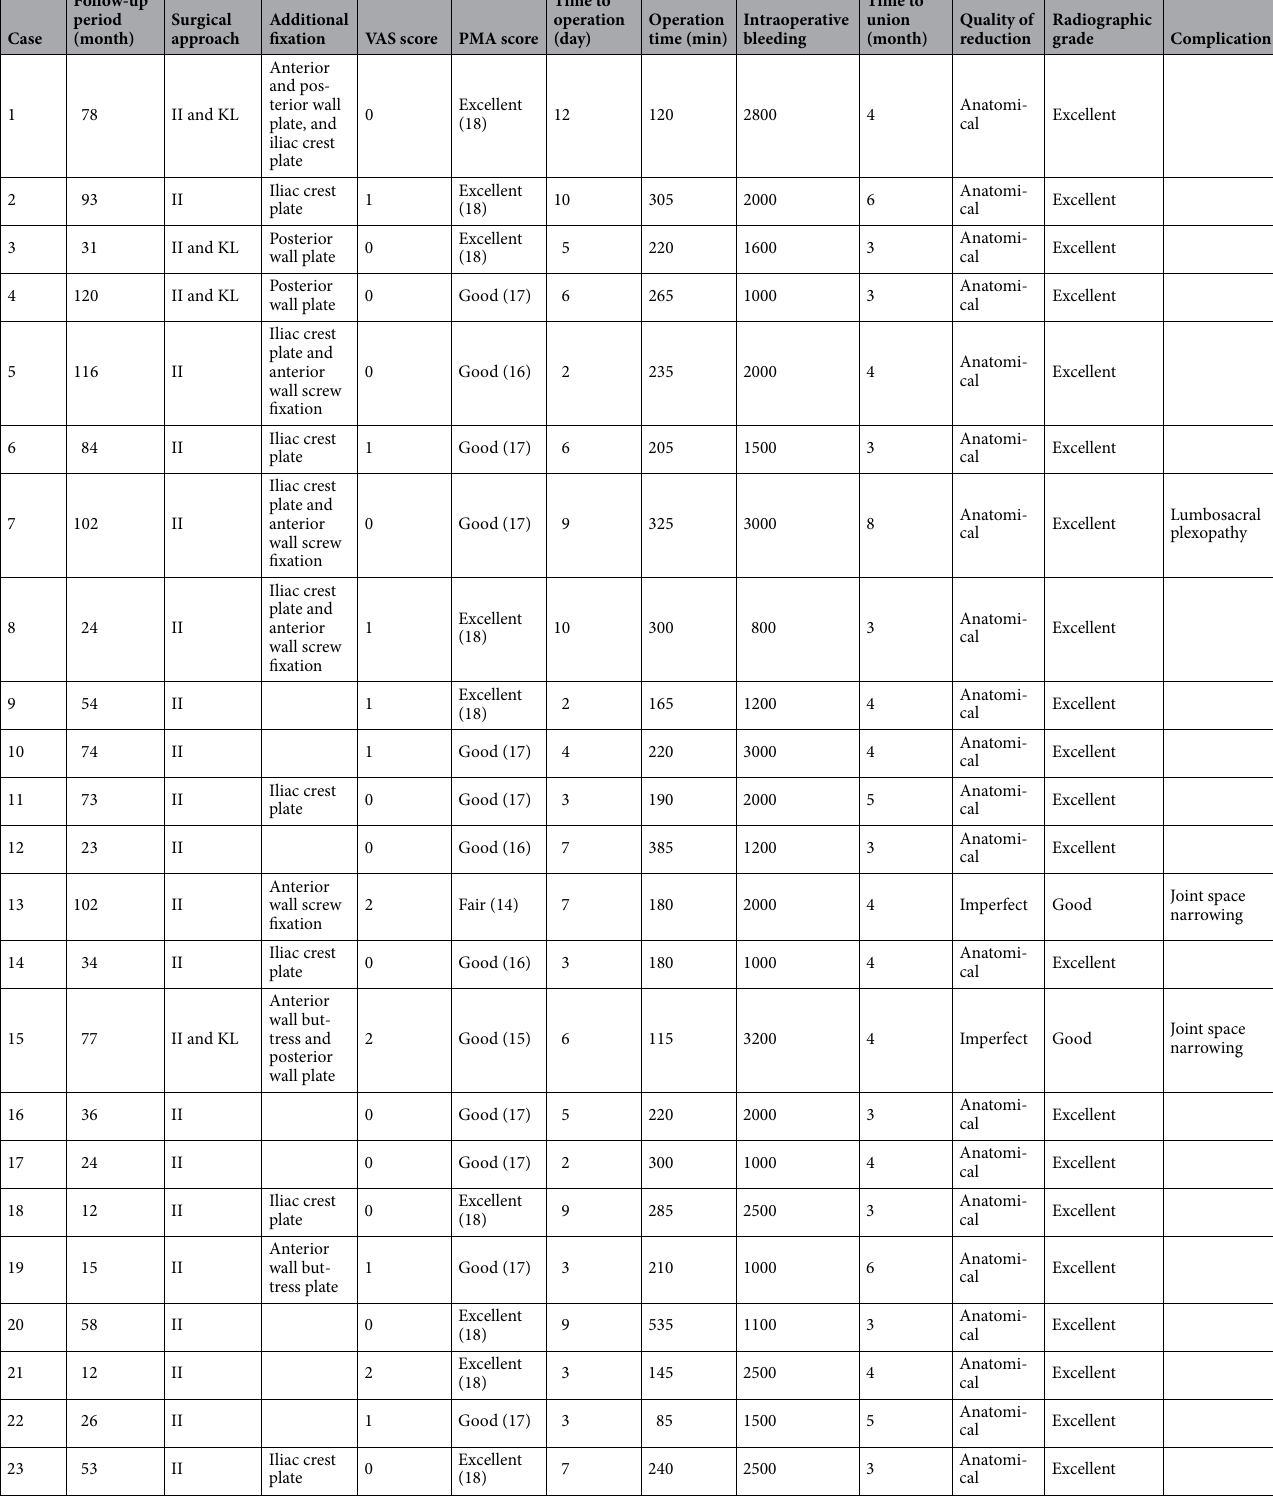
Table 4. Surgical outcomes of 23 patients using a conventional reconstruction plate through modified ilioinguinal approach. I-I Ilioinguinal, K-L Kocher-Langenbeck, VAS visual analogue scale, PMA Postel Merle